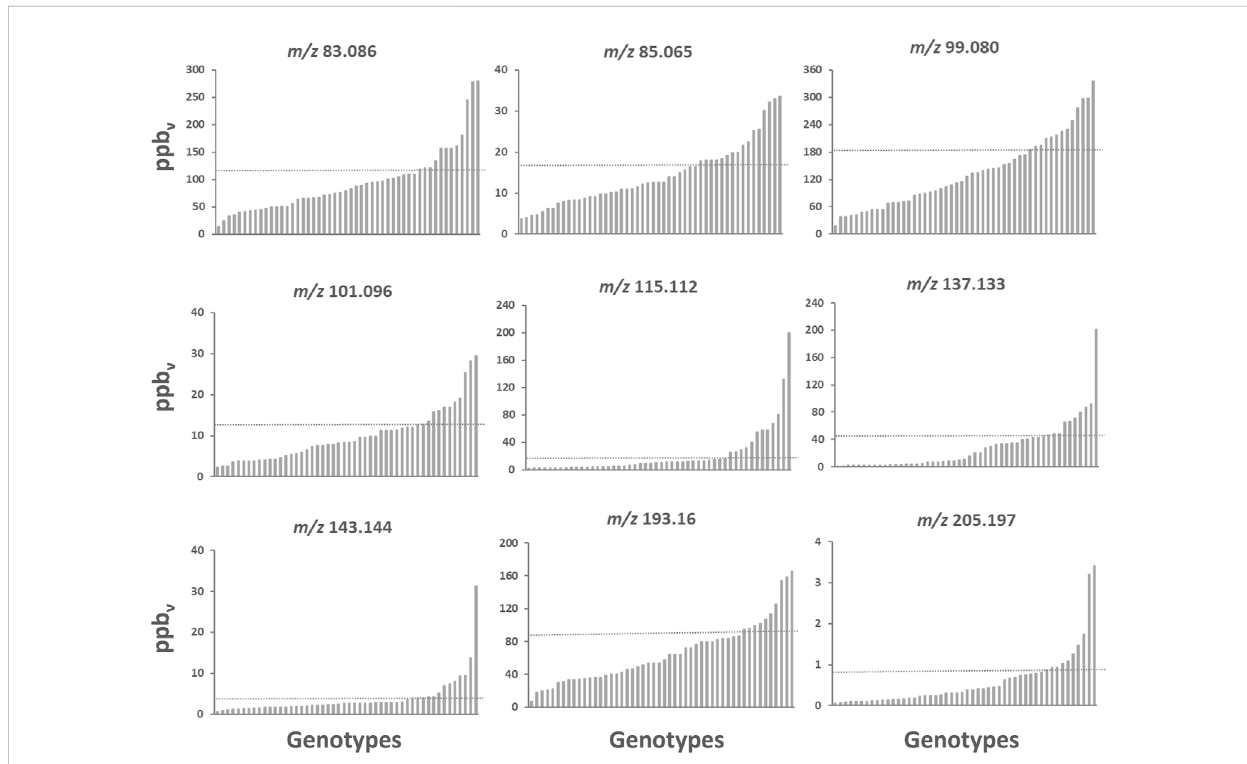
FIGURE 6 BarchartplotsofthemainraspberryVOCsassessedbyPTR-ToF-MS intheraspberrygermplasm collection. Eachbarillustratestheaveragevalueof three biological replicates. In each graph, accessions were ordered based on the VOC mass peak concentration. The 75th percentile levels are represented by the dashed line. Bar chart plots of all mass peaks with the corresponding complete names of the accessions are reported in the Supplementary Figure